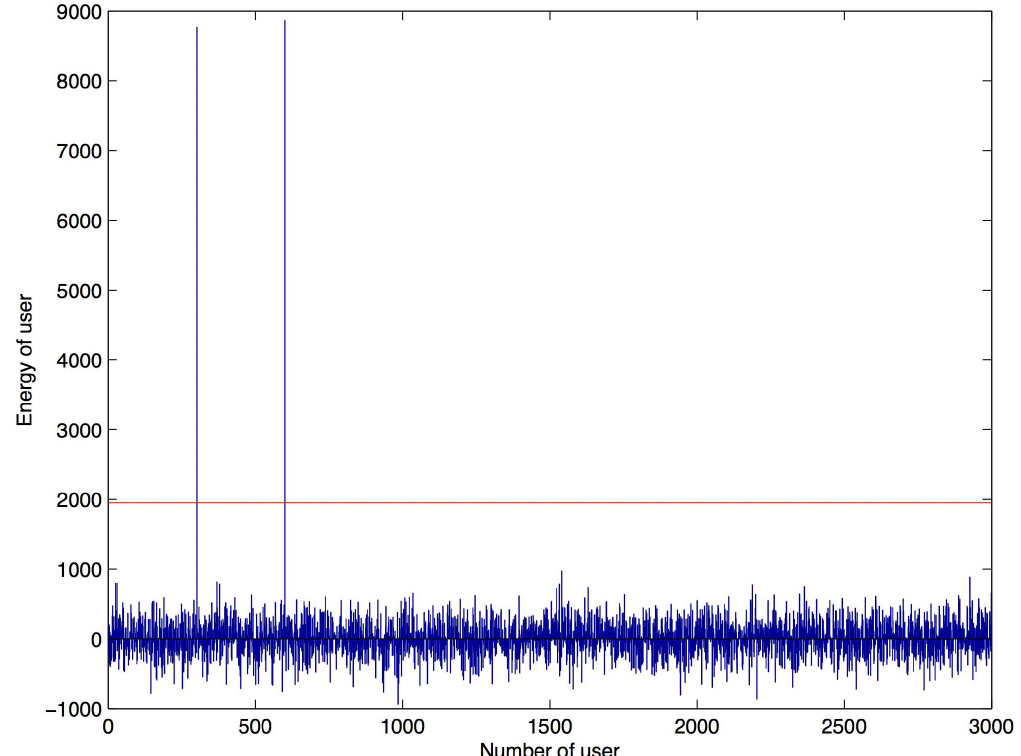
Figure 6. Detection of 2 colluders with IDs 300 and 600, with B u ~ 200,000, B g ~ 50,000, P w ~ 1 = 6 and L ~ 350,000. The red line defines the threshold value.